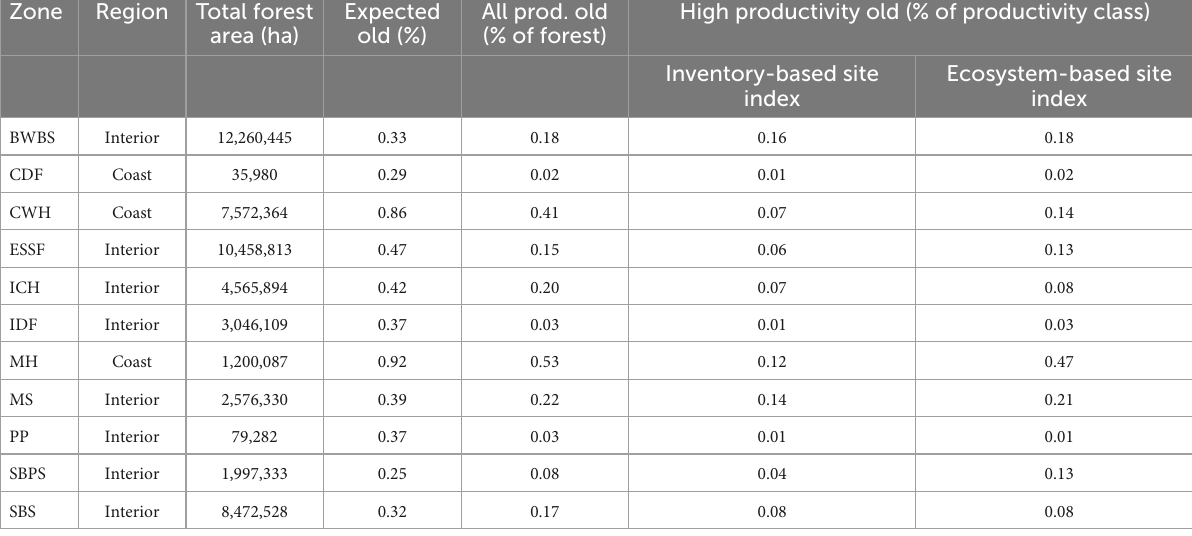
TABLE 5 Percent of total forest (all productivities) and high productivity forest that is currently old by biogeoclimatic zone based on two indicators calibrated to improve